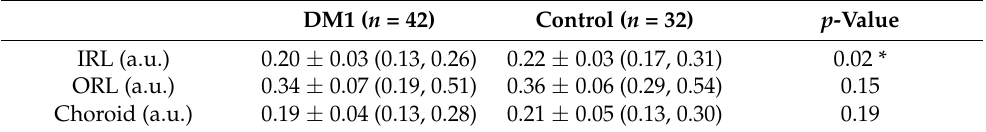
Table 3. Mean speckle contrast of inner retinal layer (IRL), outer retinal layer (ORL), and choroid, expressed in arbitrary units (a.u.). Standard deviation and range are also indicated. Independent t-test was applied for comparison between DM1 ( n = 42) and control ( n = 32) groups.